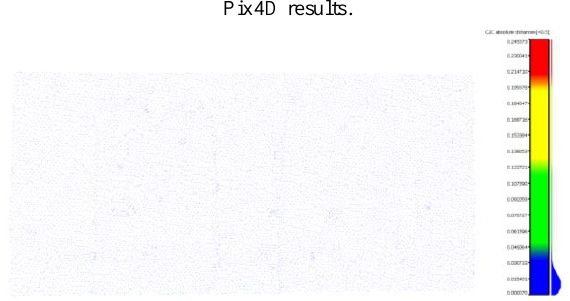
Figure 13. Discrepancies map between the TLS cloud and Pix4D results.